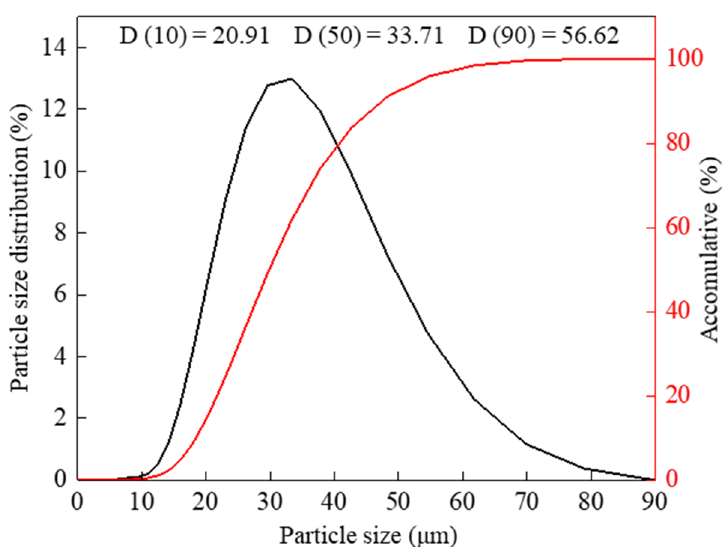
Figure 2. 316L powders particle size distribution.